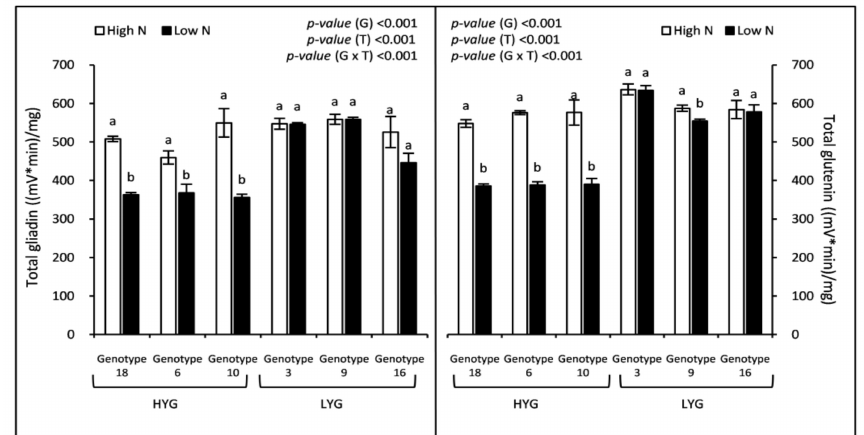
Figure 3. Grain gliadin and glutenin concentrations of 6 wheat genotypes fertilized by two nitrogen levels (High and Low). Data correspond to the means ± standard error (n = 4). For each genotype, letters indicate significant di ff erences between the two treatment. At p < 0.5. p -values corresponds to two-way ANOVA analysis. HYG: High-yielding genotypes, LYG: Low-yielding genotypes, G: Genotype, T: Treatment.